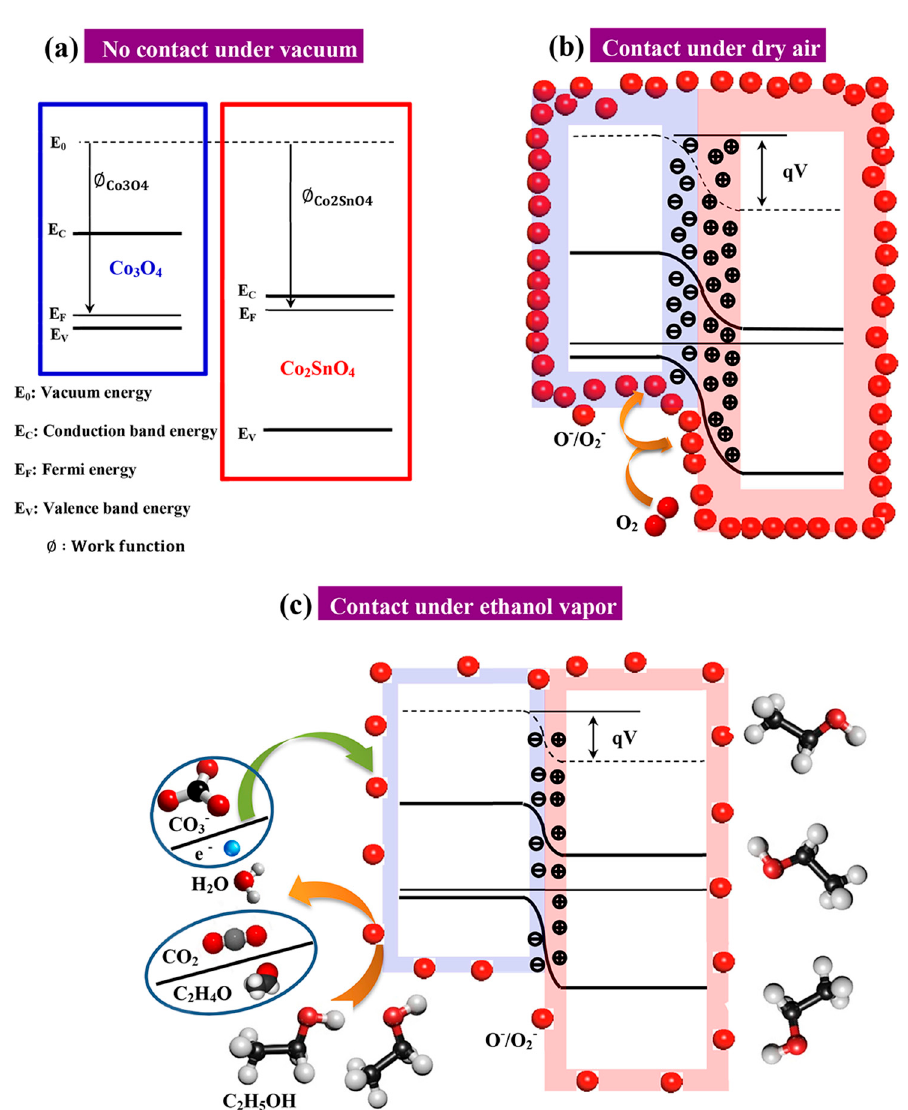
Figure 7. The energy band structure diagram and schematic diagram of the sensing mechanism of Co 3 O 4 /Co 2 SnO 4 p–n heterojunctions (CTO ann ): ( a ) no contact under vacuum; ( b ) contact under dry air and ( c ) contact under ethanol vapor.